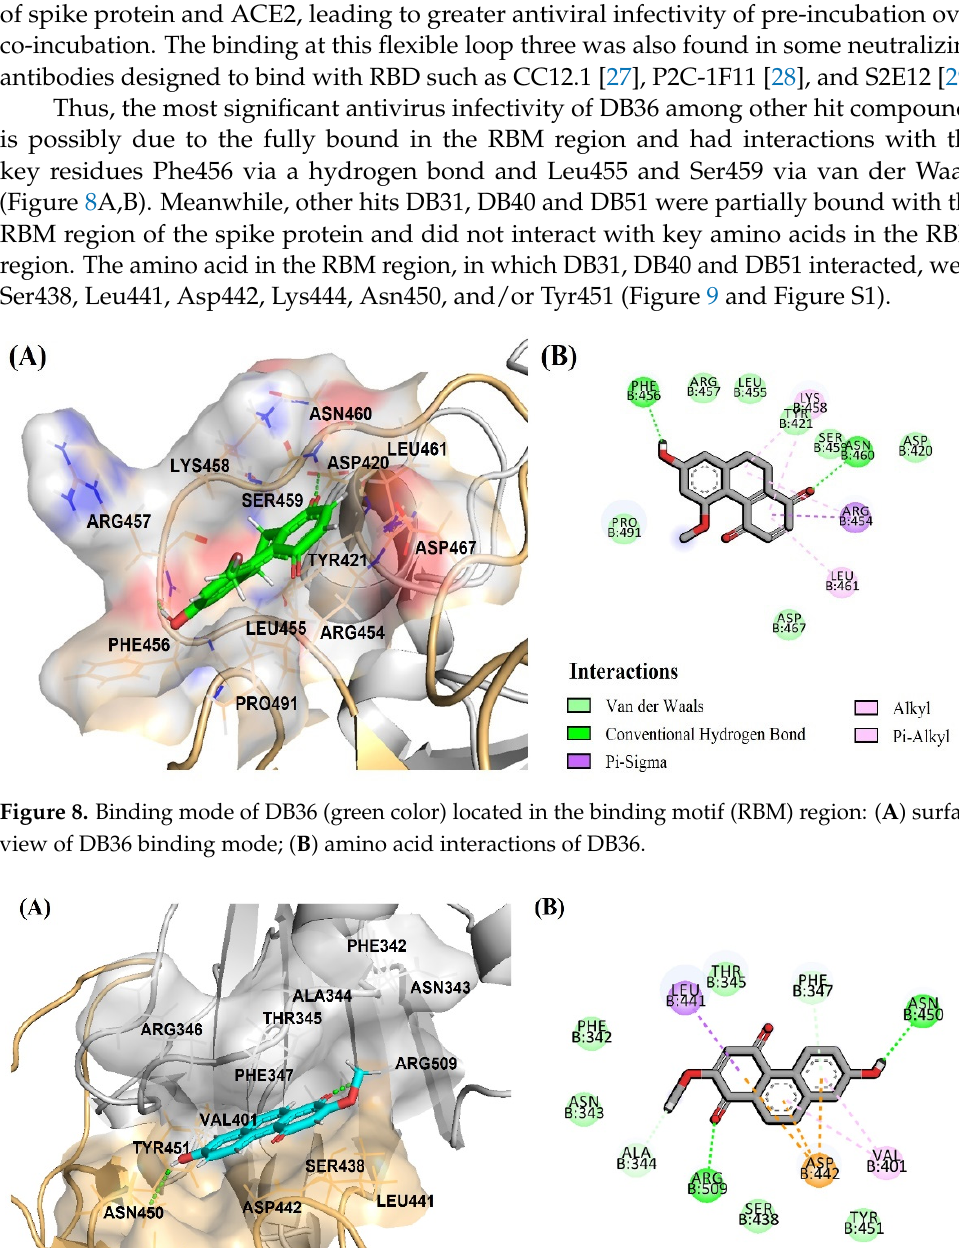
Figure 7. Binding mode of DB36 (green color stick) located in the binding motif (RBM) region (or- ange color surface) at the interface area of the spike protein interacting with ACE2 receptor (cyan helix color): ( A ) Binding location of DB36 at RBD of apo conformation of spike protein comparing with other hits; ( B ) The superimposition of the docked pose of DB36 with the ACE2 bound confor- mation of the spike protein (PDB code: 7KMB, pink color); The red arrow showed the flexible loop three (residues 472–490) of the spike protein in conformations of ( A ) apo (orange color) and ( B ) ACE2 bound (pink color); ( C , D ) The interactions of DB36 with the residues at the interface area of the spike protein interacting with the ACE2 receptor.